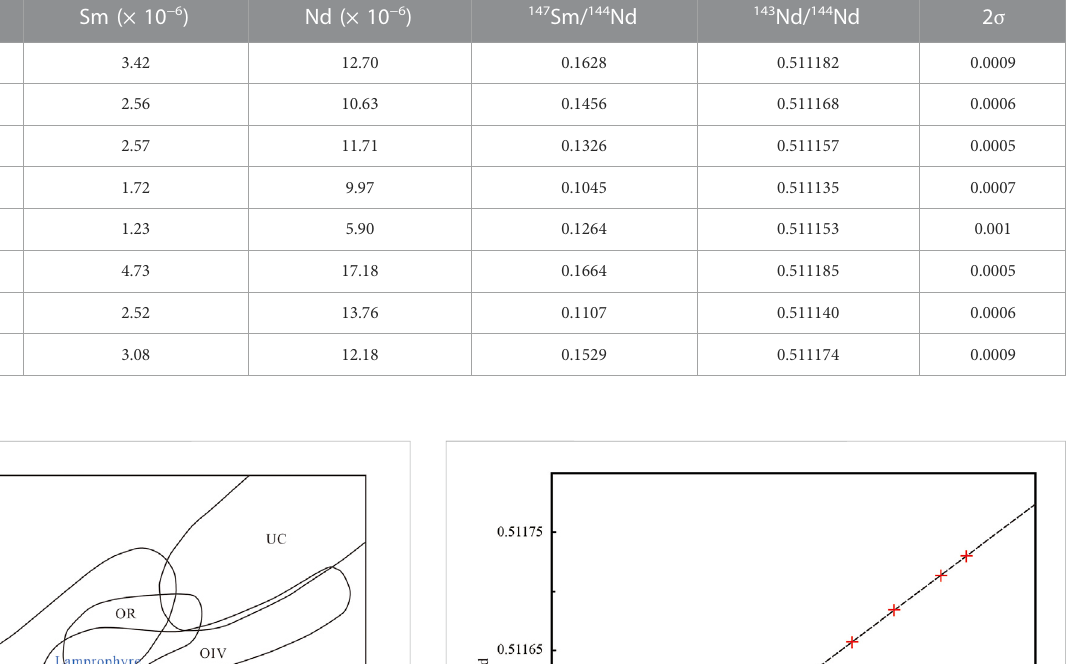
TABLE 4 Sm-Nd isotopic compositions of calcites from the Yangjiakuang gold deposit. Sample No.